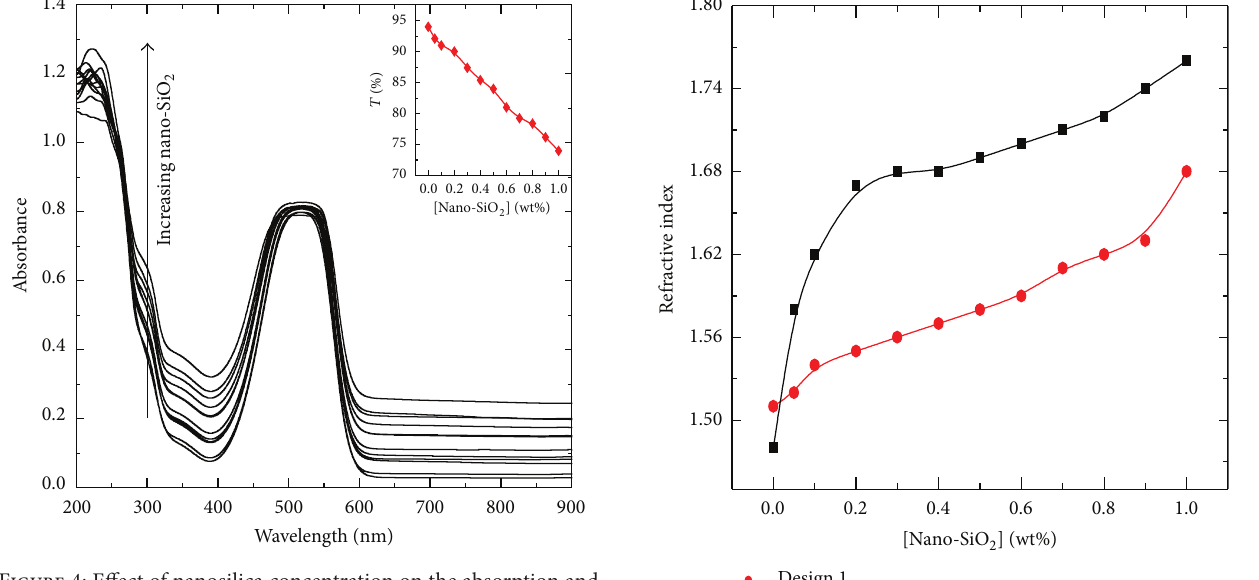
Figure 4: Effect of nanosilica concentration on the absorption and transmission (inset) spectra of design (1) TLSCs.